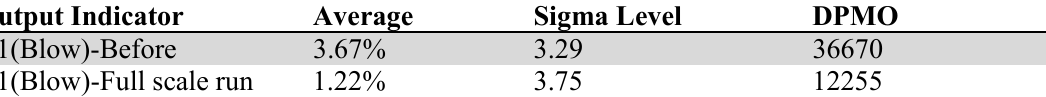
Full scale implementation Plan